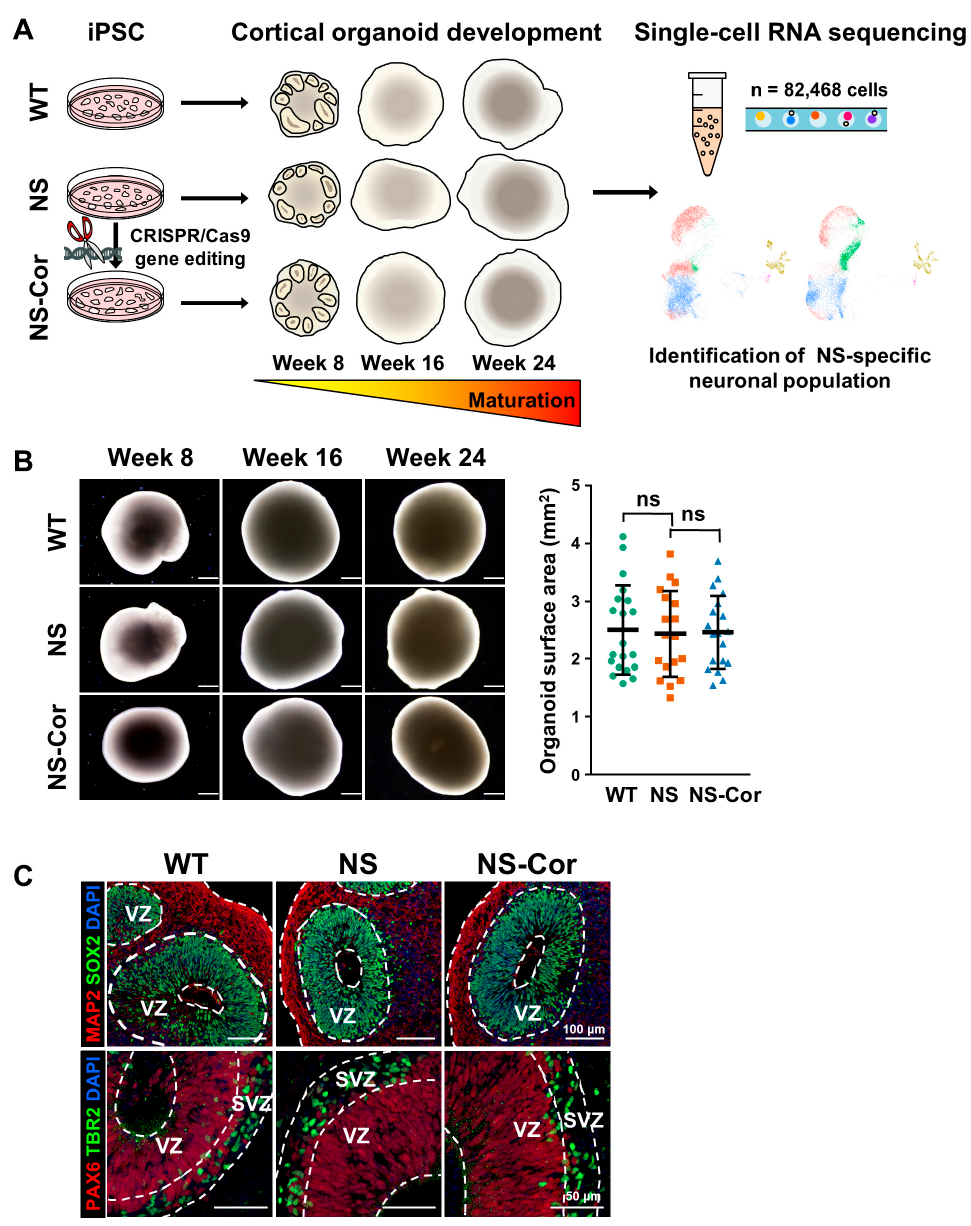
Figure 1. Normal development of NS-iPSCs to COs. ( A ) Schema of the experimental procedures. ( B ) Normal morphological development of NS-COs. No differences were observed in the surface areas of week 8-COs among the WT-, NS-, and NS-Cor-groups. The surface areas of 18–20 organoids in each group were measured using ImageJ and repeated independently three times. Data are